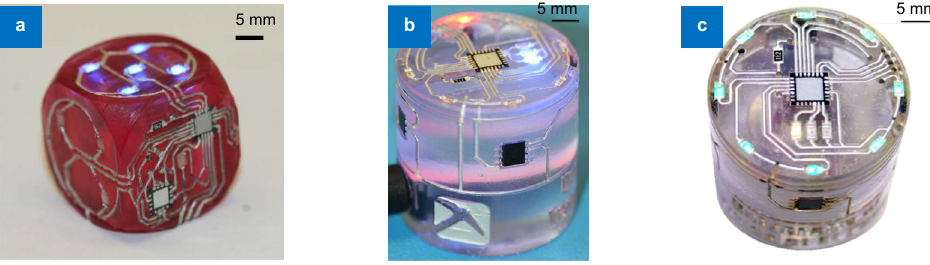
Fig. 8 | Examples of printed 3D structural electronics 18 . ( a ) A gaming die which includes a microcontroller and accelerometer. ( b , c ) A magnetometer system with microprocessor and orthogonal Hall Effect sensors.